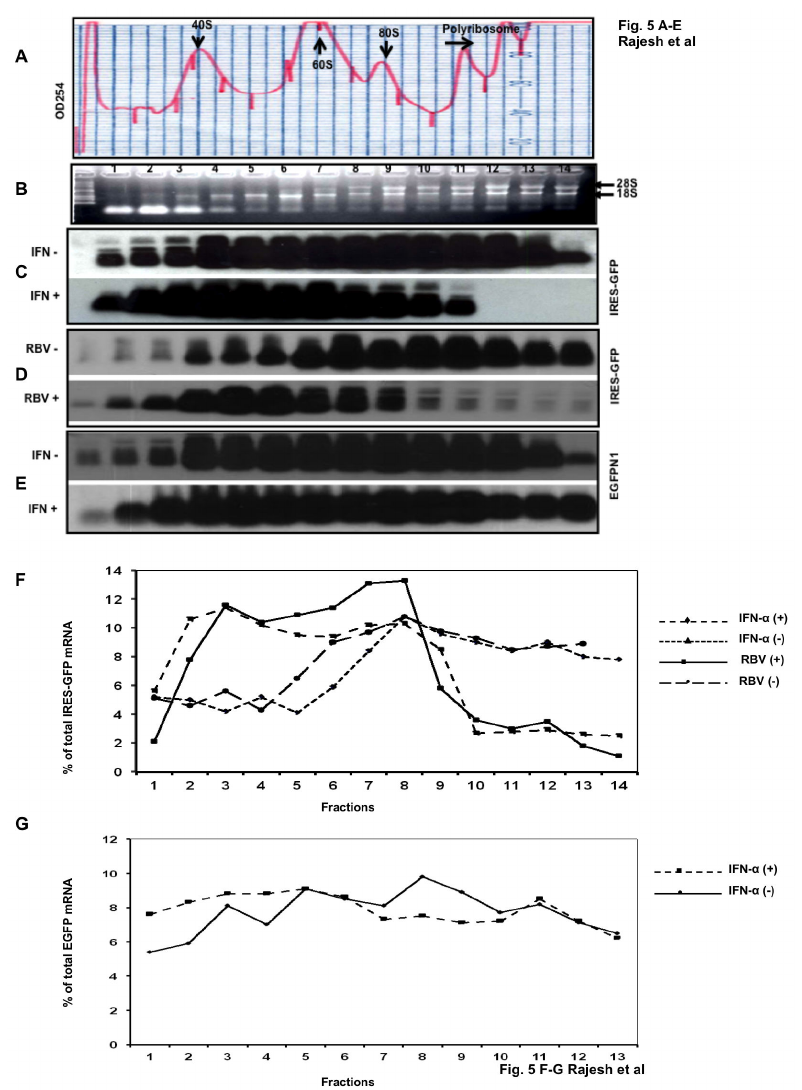
Figure 5. The distribution of HCV IRES-GFP mRNA in the monosome and polysomes fractions in the Huh-7 cells with (+) and without (-) IFN-α and RBV treatment. ( A ) Illustrates the separation of monosome and polysomes along the sucrose gradient fractions (1 to 14). The values indicate the spectrophotometry of optical density of the polysome fractions at 260 nm wavelengths. The point arrow shows the 60S, 80S and separation between monosomes and polysomes in the gradient fractions. ( B ) Formaldehyde agarose gel electrophoresis and ethidium bromide staining of RNA samples isolated from the corresponding gradient fractions of untreated Huh-7 cells. The 18S and 28S band appears on the gel throughout the fractions and it become more intense on the 80S fractions of the gradient as expected. ( C ) Shows the distribution of HCV IRES-GFP mRNA in the monosome and polysome fractions by Northern blot analysis using a riboprobe targeted to the 5’ UTR. In the untreated IFN (-) cells the IRES-GFP mRNA efficiently translated and formed polyribosome complexes (Lane 11-14). But the IFN treatment (+) prevented polysome formation on IRES-GFP mRNA (Lane 11-14). ( D ) In the RBV untreated Huh-7 cells, the IRES-GFP mRNA efficiently translated and formed polyribosome complexes (Lane 11-14). RBV treatment (+) prevented polysome formation on IRES-GFP mRNA (Lane 10-14). ( E ) Similar experiment was performed where the effect of IFN-α or RBV treatment on the distribution of EGFP mRNA was examined by Northern blotting using RNA probe specific to GFP. IFN-α treatment did not alter the distribution of EGFP mRNA that translates by non-IRES dependent mechanism. ( F ) Comparison of the relative amount of HCV IRES and non-IRES mRNAs in monosome and polysome fractions in the sucrose density gradient analysis generated from the transfected cells. Density of the Northern blot was measured using an image analysis computer software (Total Lab, TL120). Values are expressed as percentage of total mRNA recovered from the gradient versus the mRNA present in each fraction. ( G ) The formation of polyribosome of EGFP mRNA was not altered by IFN-α treatment. doi: